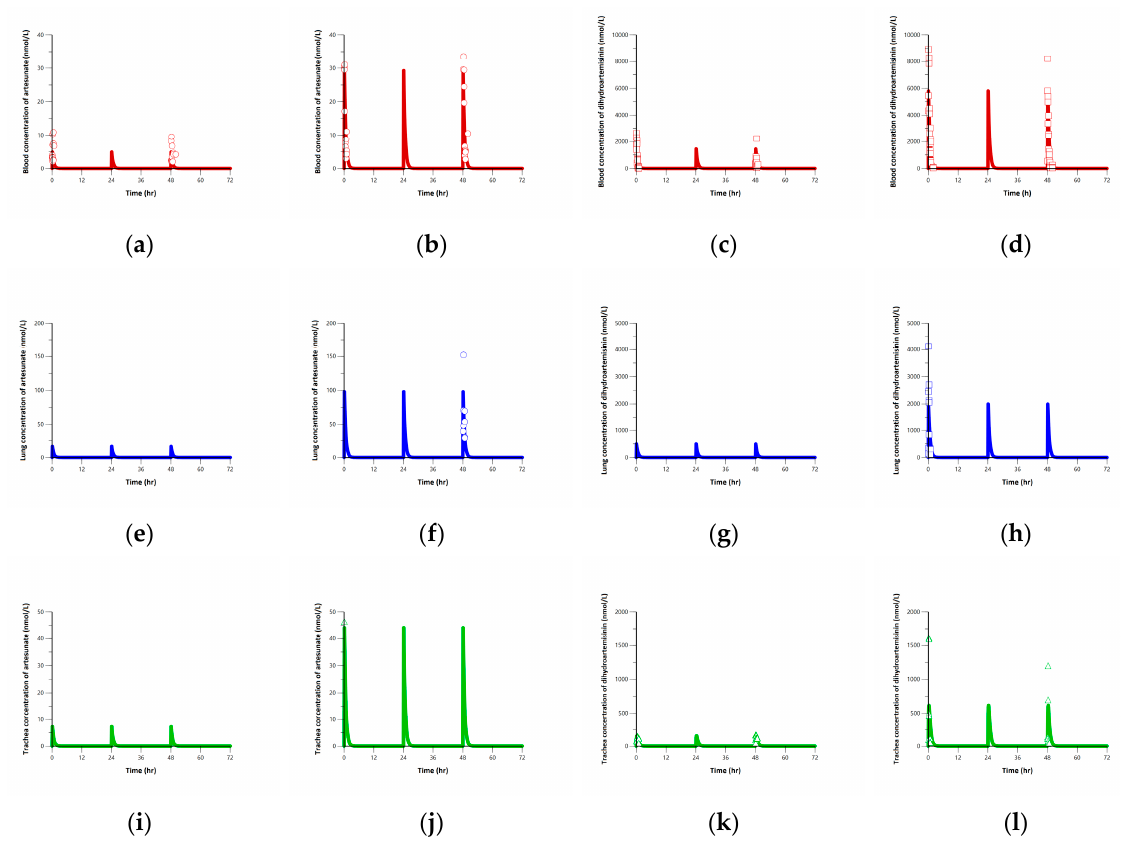
Figure 7. Simulated PK profiles for daily oral dosing of artesunate with low- and high-dose for 3 days. Blue, green, and red solid lines are simulated profiles for lung, trachea, and blood, respectively. Circles and squares are observed concentrations of artesunate and dihydroartemisinin, respectively. Blood concentrations of artesunate in low-dose ( a ) and high-dose ( b ) group; blood concentrations of dihydroartemisinin in low-dose ( c ) and high-dose ( d ) group; lung concentrations of artesunate in low-dose ( e ) and high-dose ( f ) group; lung concentrations of dihydroartemisinin in low-dose ( g ) and high-dose ( h ) group; trachea concentrations of artesunate in low-dose ( i ) and high-dose ( j ) group; trachea concentrations of dihydroartemisinin in low-dose ( k ) and high-dose ( l ) group. A minimum toxic concentration (MTC) or minimum effective concentration